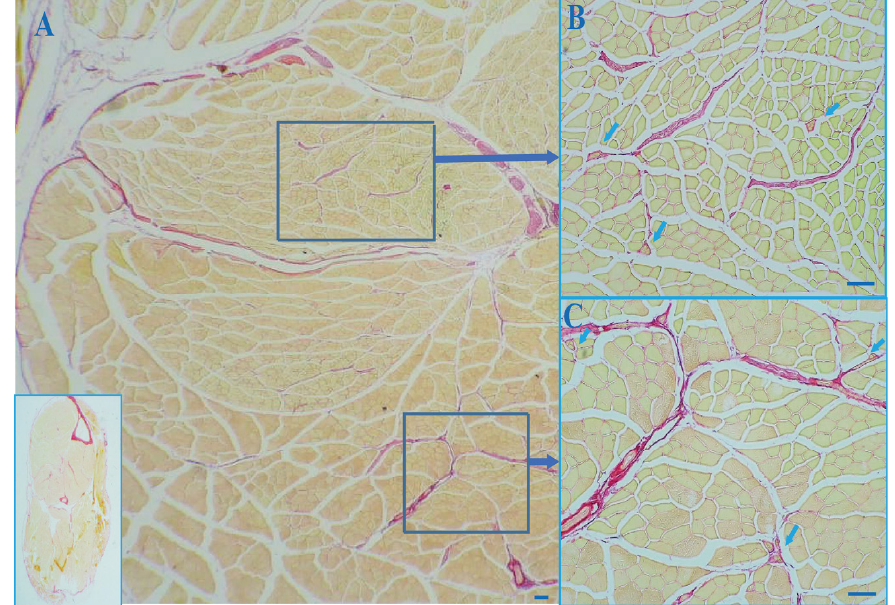
Figure 1. Picrosirius red staining of a cross section of a muscle of a mouse hindlimb. The inset in ( A ) on the bottom left corner is the whole crosse section of the mouse hindlimb. The MS capsule appears to be continuous with the perimysium, epimysium, and the endomysium. ( A ): Global view of the cross section. ( B , C ): MSs within the skeletal muscle. arrows: muscle spindles. Scale bar: 100 µ